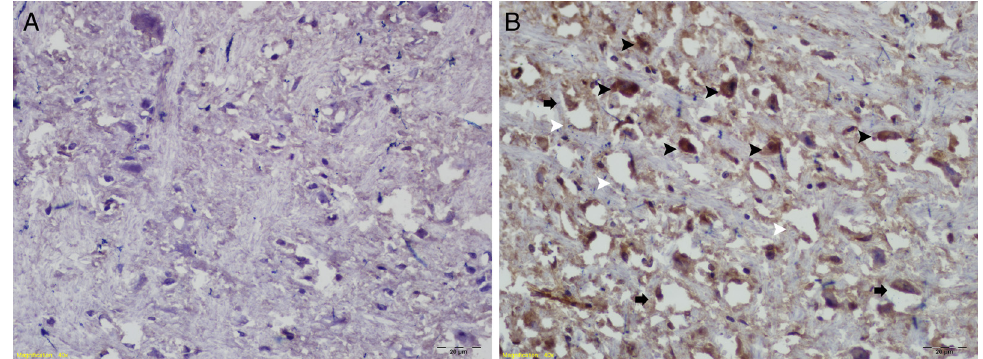
Figure 2 TUNEL staining results; (A) control group; (B) study group: apoptotic cells (black arrowheads), pyknotic neurons (black arrows), diffuse vacuolated areas (white